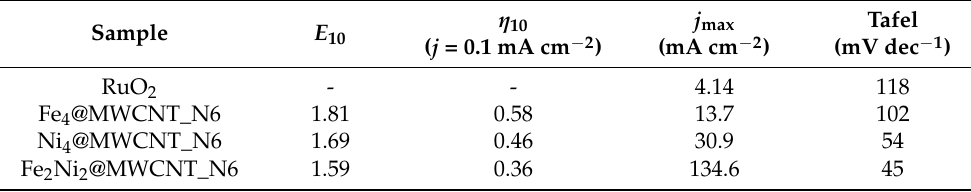
Table 4. The OER performance parameters for all the materials